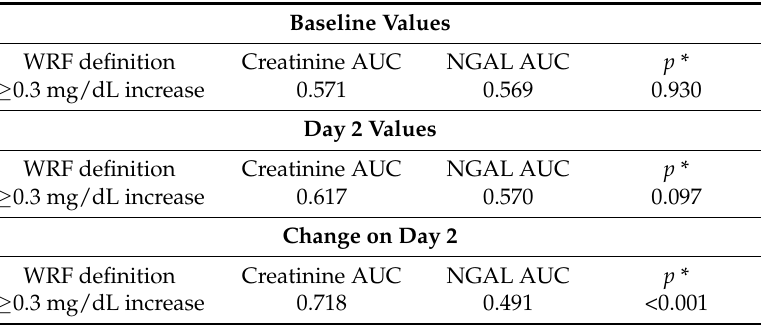
Table 2. Predictive value of NGAL and Creatinine for WRF.